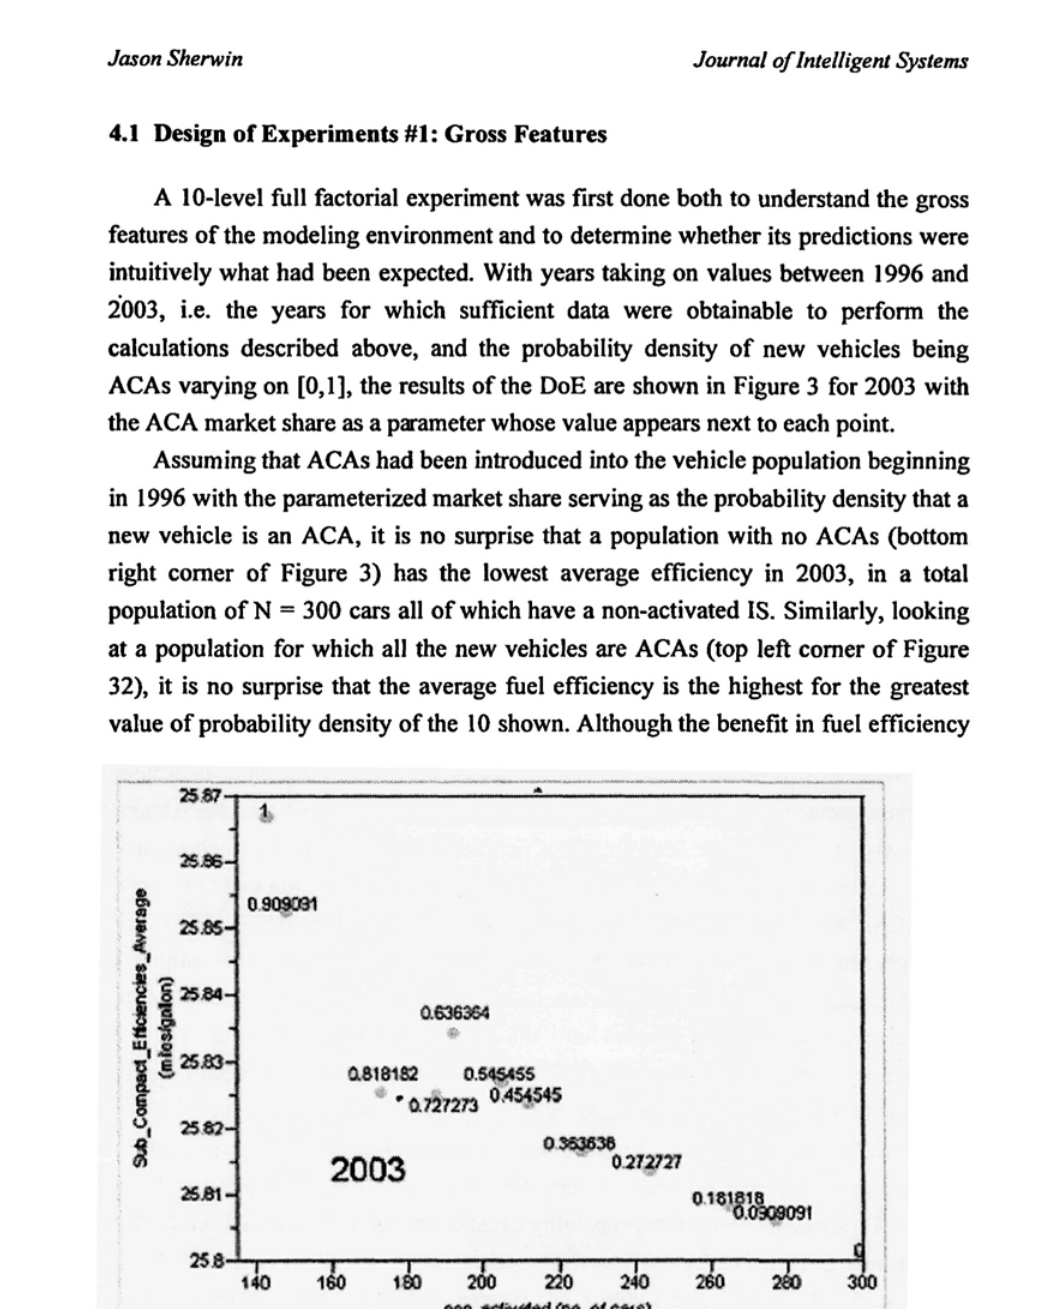
Fig. 3: Sub-compact fuel efficiencies vs. number of IS non-activated